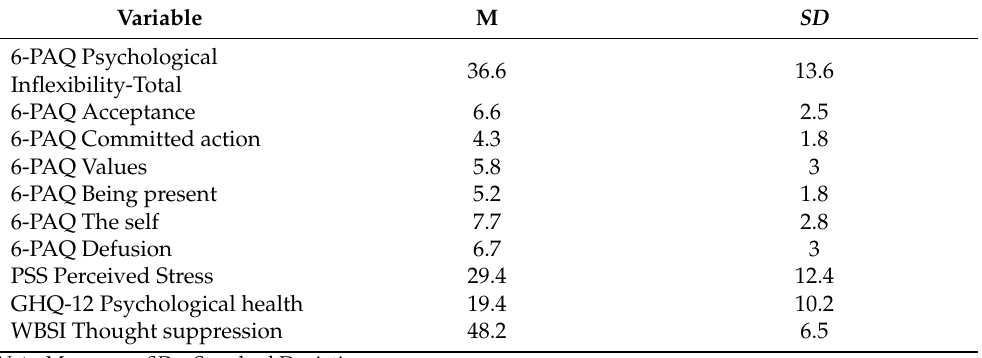
Table 1. Scores obtained on the scales and subscales for the whole sample.